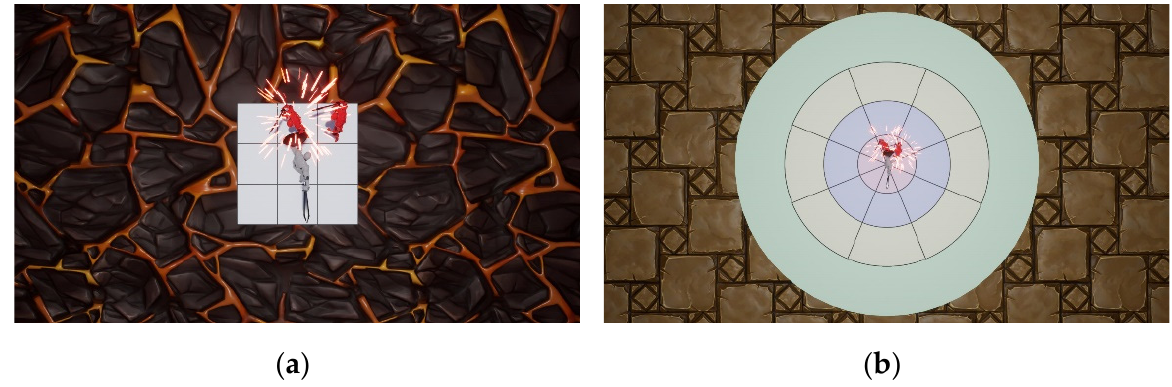
Figure 6. Tests for the interaction area between enemies and the player. ( a ) BAI; ( b ) IBAI.